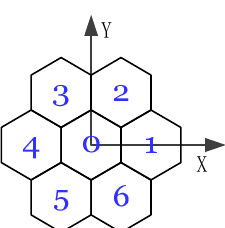
Figure A1. An example of the definition of the initial cells at the level 0: this example assigns 7 cells for the level 0 (source—own study). Table A1. An example of addition tables for the grid with 4 levels: ( a ) addition table for the digit position of the level 1; ( b ) addition table for the digit position of the level 2; ( c ) addition table for the digit position of the level 3.